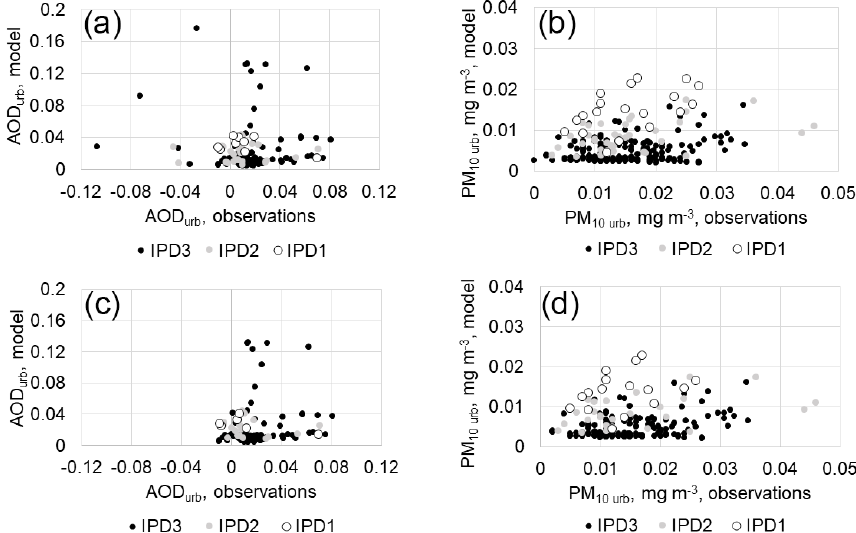
Figure 11. The relationship between model and measured urban aerosol optical depth at 550nm (AOD urb – a, c ) and the urban component of PM 10 (PM 10urb , mgm − 3 – b, d ) for all the cases ( n = 229) (a, b) and for the cases without the effects of urban air advection from Moscow to Zvenigorod ( n = 203) (c, d) under different IPD conditions. For consistency reasons, we show only quasi-simultaneous AOD and PM 10 measurements during the daytime period with AOD observations. The cases affected by biomass burning aerosol were excluded.